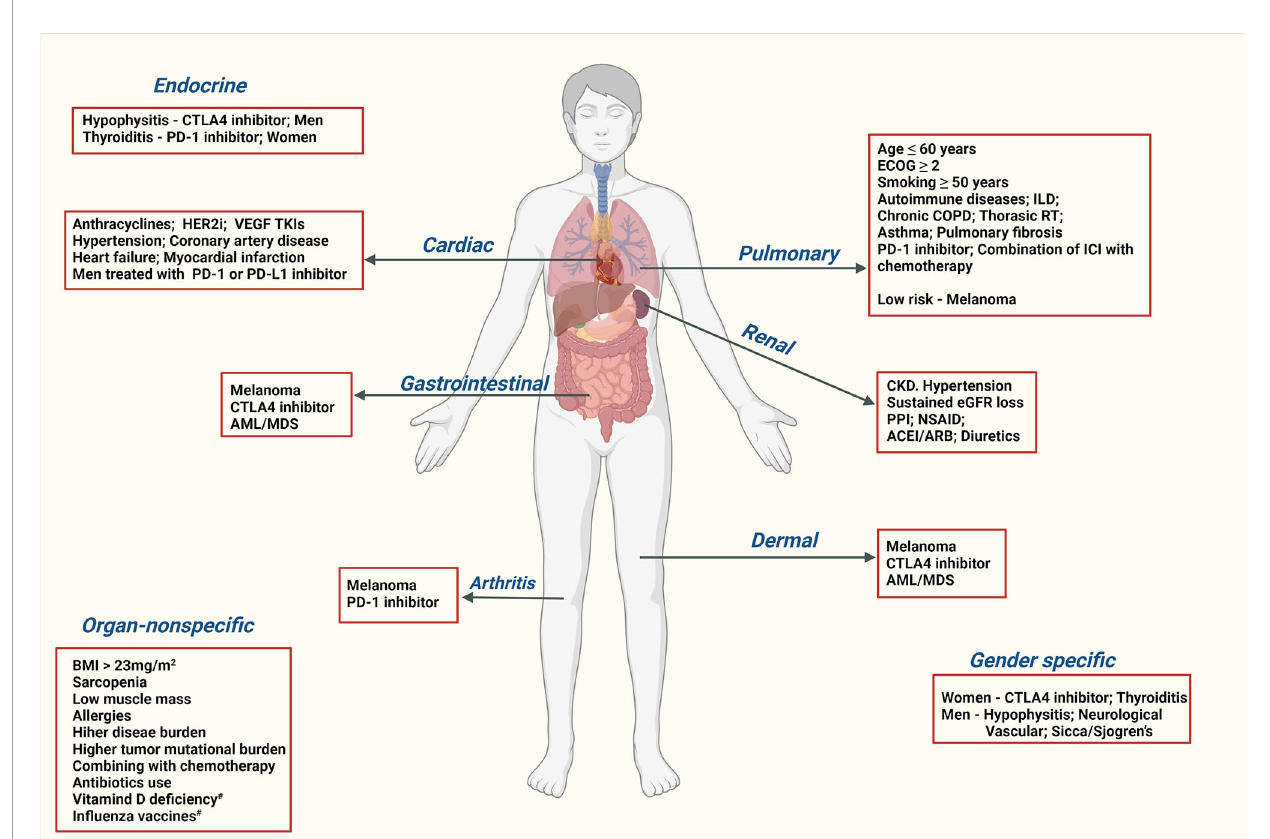
FIGURE 1 | Risk factors for immune-related adverse events. CTLA4, Cytotoxic T-Lymphocyte Antigen 4; PD-1, Programmed Cell death-1; PD-L1, Programmed death-ligand 1; irAE, immune-related adverse events; HER2i, human epidermal growth factor receptor 2 inhibitors; VEGF, Vascular endothelial growth factor; TKI, Tyrosine Kinase Inhibitor; HLA, Human leukocyte antigen; AML, acute myeloid leukemia; MDS, myelodysplastic syndromes; BMI, body mass index; ECOG, Eastern Cooperative Oncology Group; ILD, interstitial lung disease; COPD, Chronic obstructive pulmonary disease; RT, radiation therapy; CKD, chronic kidney disease; AKI, acute kidney injury; PPI, Proton-pump inhibitors; NSAID, nonsteroidal anti-in fl ammatory drugs; ACE, angiotensin-converting enzyme inhibitors; ARB, angiotensin receptor blockers; # , there is weak evidence for these risk